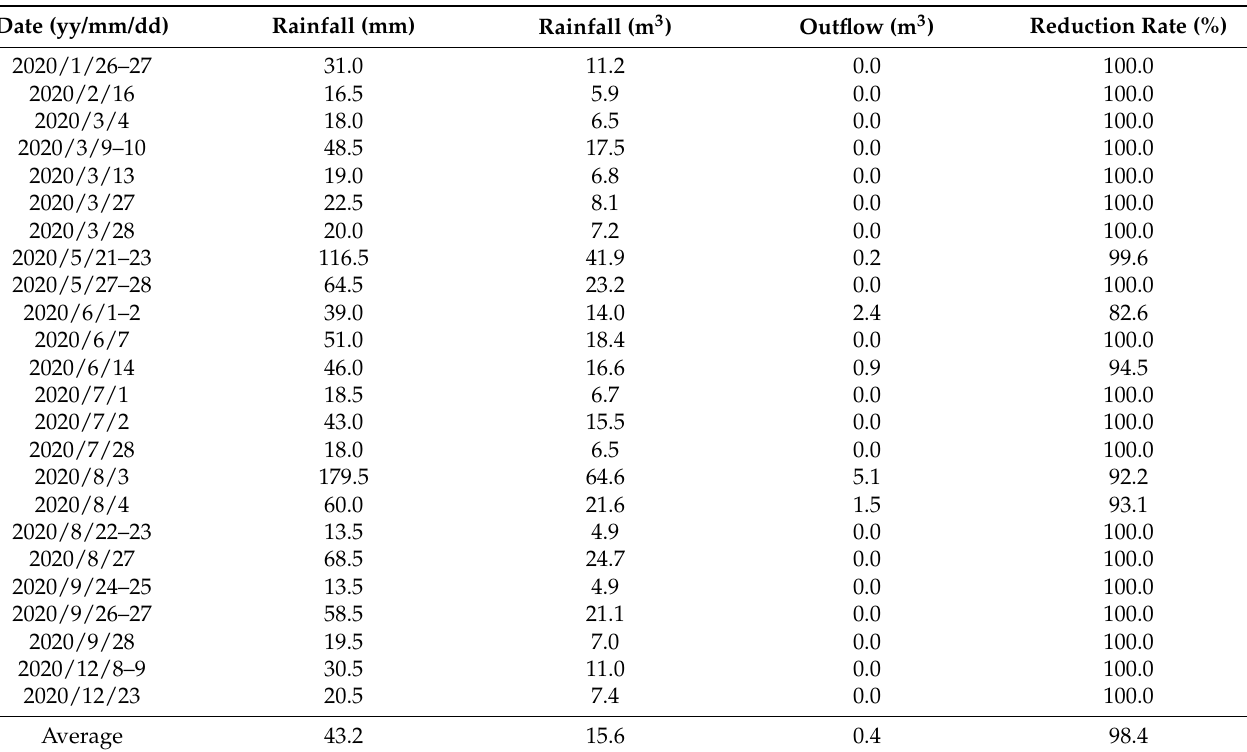
Table 2. Observed rainfall events at the raingarden